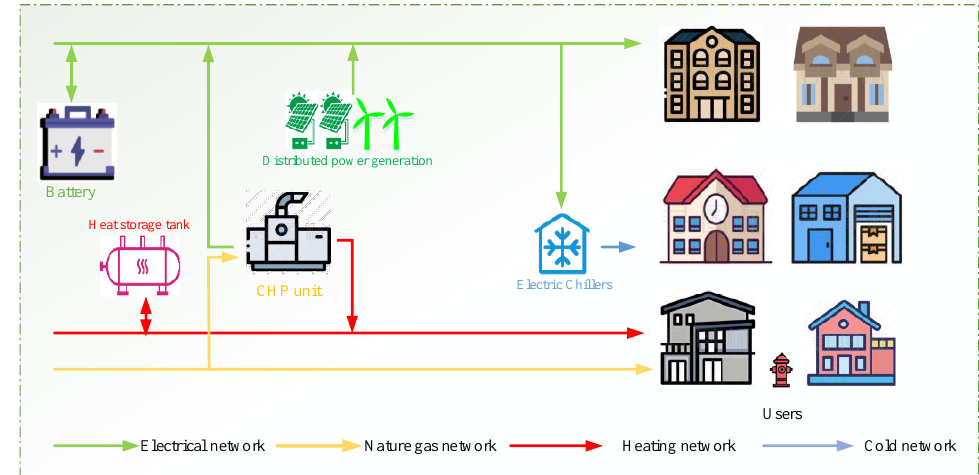
Figure 1. Physical architecture diagram for an integrated energy